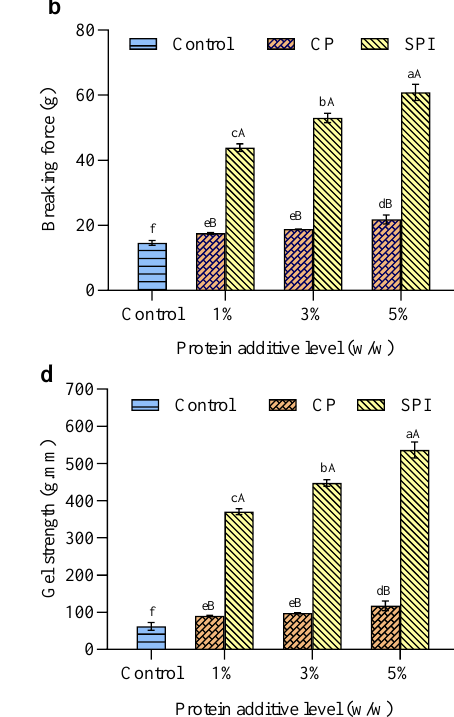
e B g Figure 2. Effects of the addition of cricket powder (CP) and soy protein isolate (SPI) at different concentrations on TCA-soluble peptide ( a ), breaking force ( b ), deformation ( c ), gel strength ( d ), ex- pressible moisture ( e ), whiteness ( f ), and appearance ( g ) of mackerel surimi gels. Bars represent standard deviation from triplicate determinations. Different uppercase letters between additives at the same level and different lowercase letters in all samples indicate significant differences ( p < 0.05).